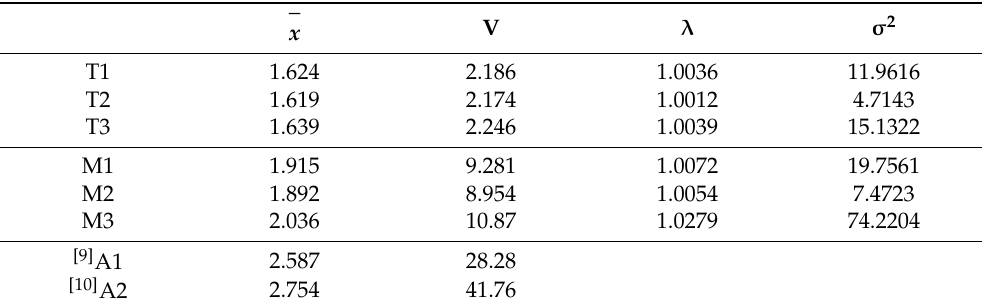
Table 13. Comparison of mean bond distances, polyhedral volume (A 3 ), and distortion parame- ters [28] (quadratic elongation λ bond angle variance σ 2 ) for coordination polyhedra in hancockite. ¯ x V λ σ 2